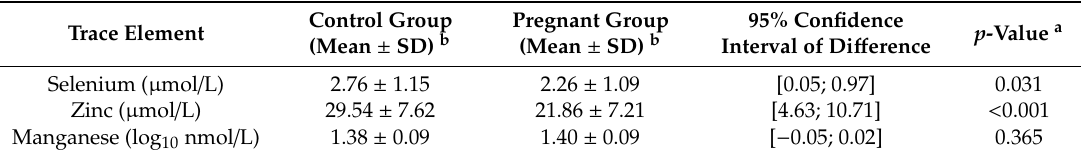
Table 2. Concentrations of selenium, zinc, and manganese in blood serum of pregnant women as compared to the control